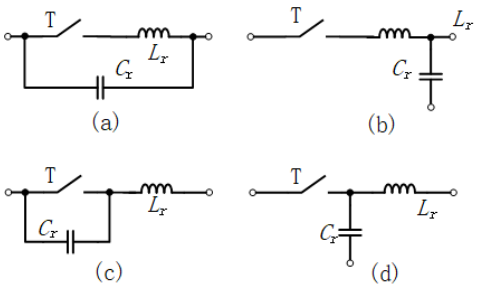
Figure 11. Switching units of QRCs. ( a , b ) Achieving ZCS. ( c , d ) Achieving ZCS.